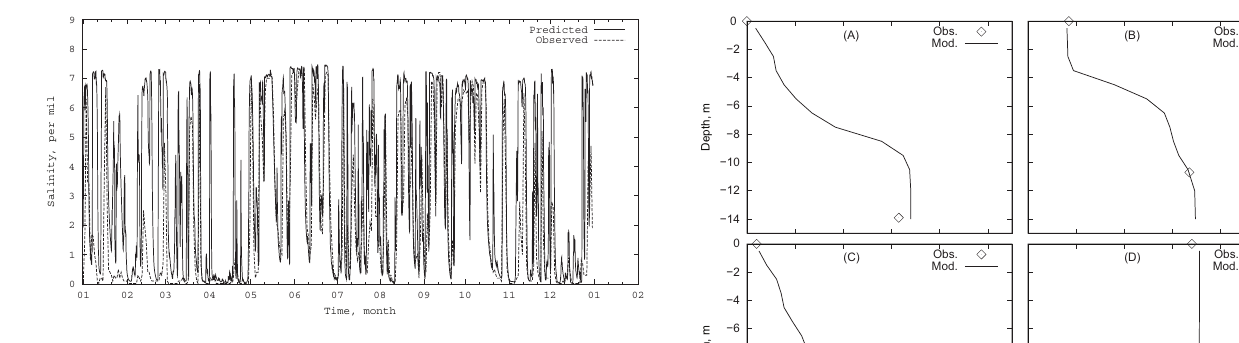
For the investigation of horizontal distribution for salin- ity vertical gradient strength the difference between bottom layer salinity and surface layer salinity is shown in Fig. 4d. The highest differences between surface and bottom salinity (2.5–3 ‰) are observed in Klaip˙eda Strait (Fig. 4d). To the south of Kiaules Nugara Island the differences in most cases are less than 0.5 ‰. This result indicates that Klaip ˙ eda